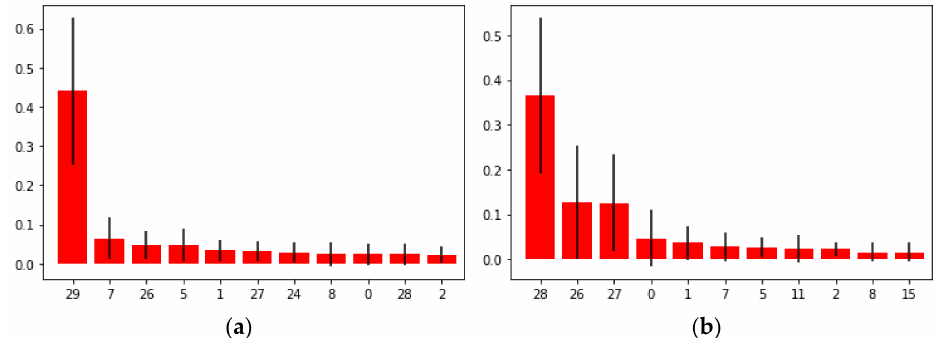
Figure 8. GINI index-based significance of the features of RF: ( a ) Data Set I; ( b ) Data Set II (the feature ID is referred to Table